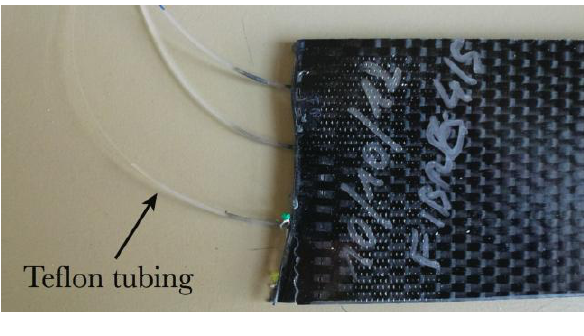
Figure 8. Protective loose tube in Teflon around the optical